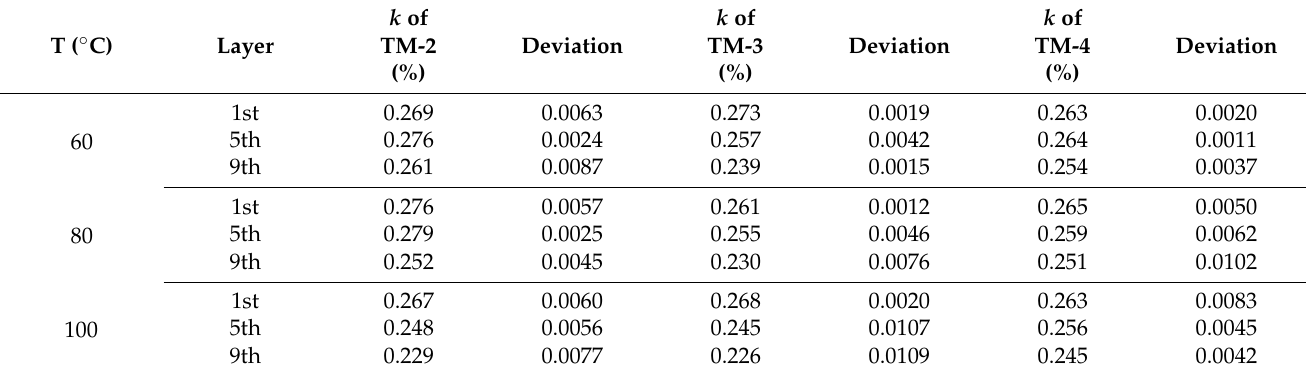
Table 4. Free drying shrinkage coefficient of a representative layer on the thickness of the test material at different parts in the length direction of Mongolian Scotch pine sawn timber.